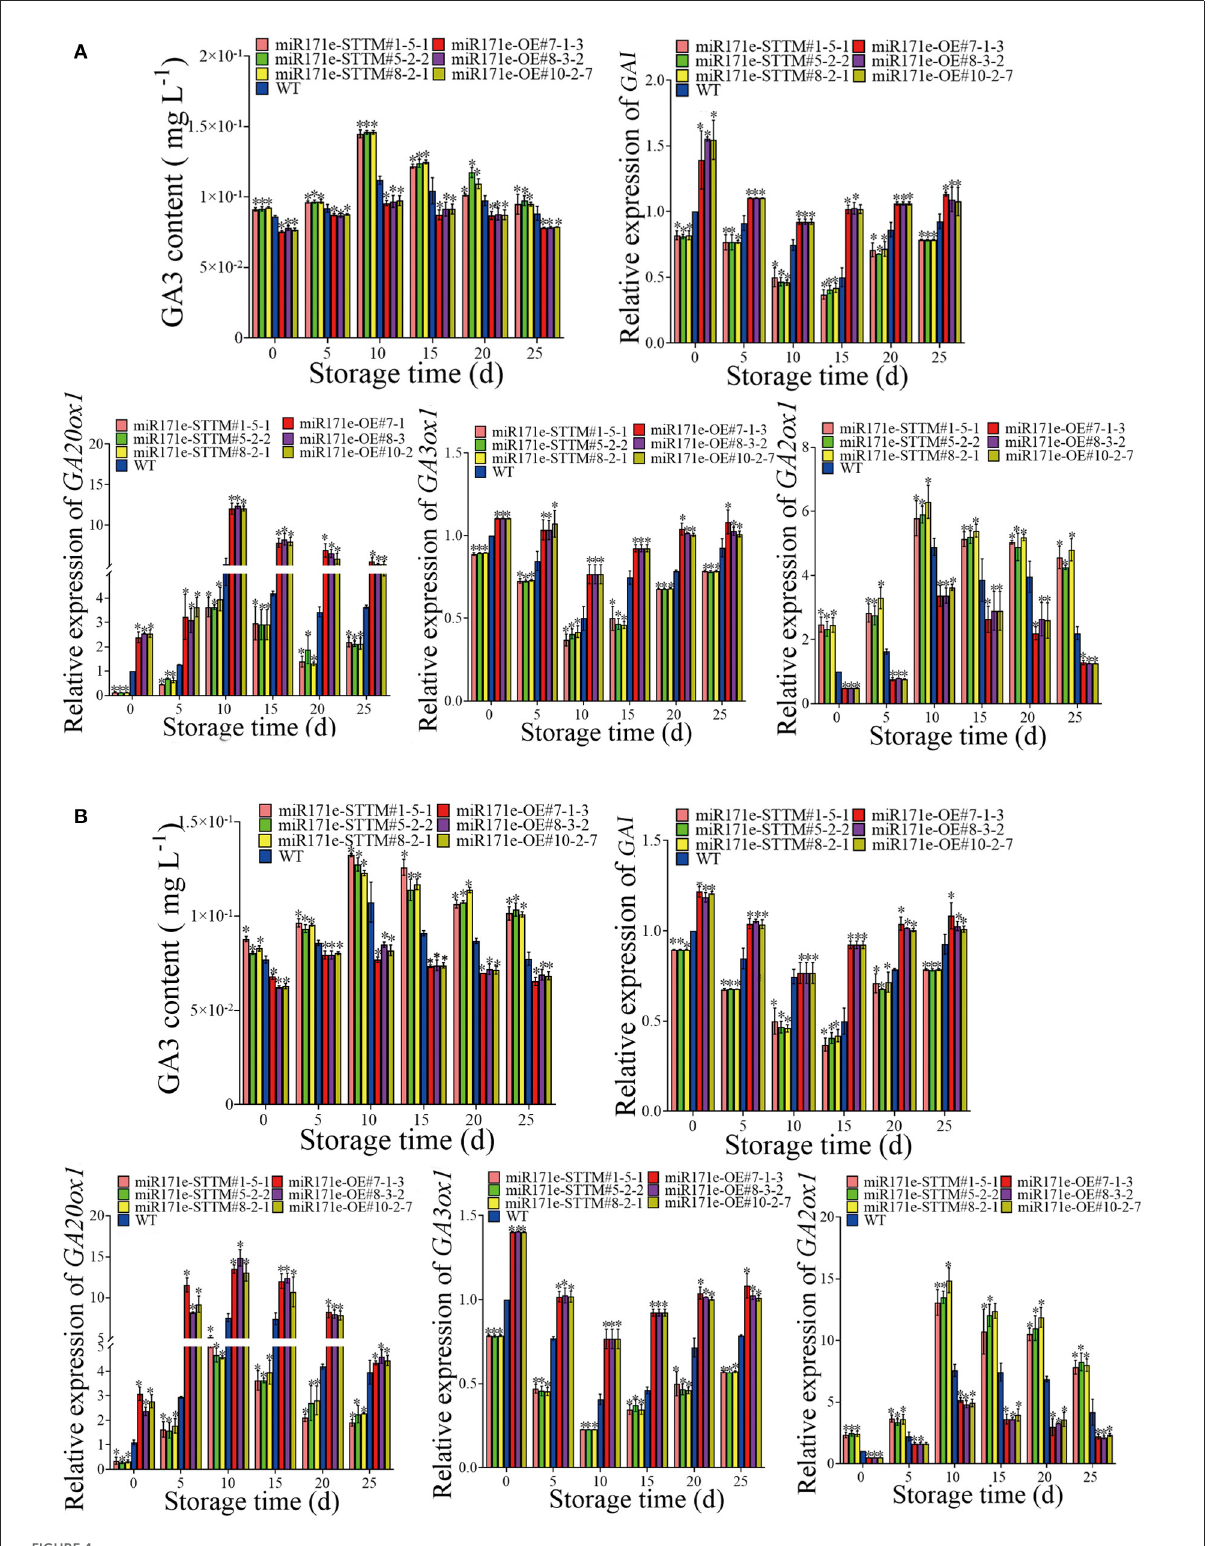
FIGURE4 The GA3 content and the related gene expression in tomato fruit at MR (A) and MG stage (B) . Vertical bars represent standard deviations of the means, n = 3. Asterisks indicate the statistical difference in the significance at * p < 0.05.